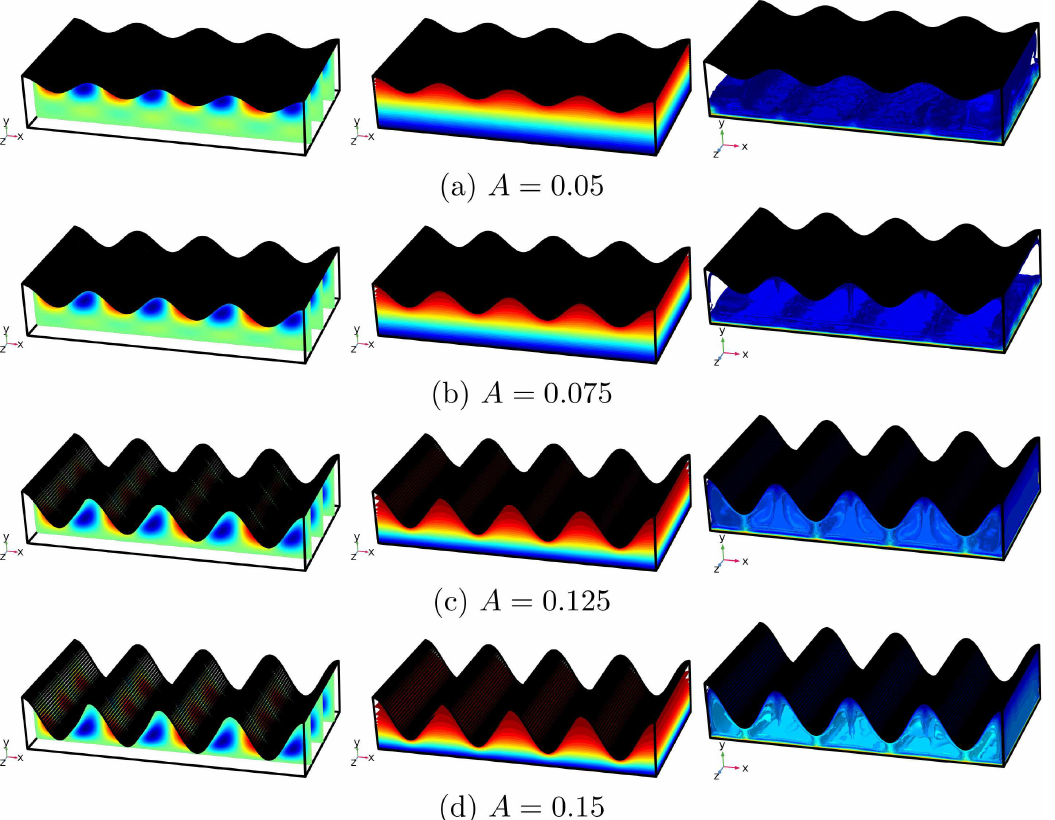
Figure 7. Variation of the 3D streamlines ( left ), isotherms ( middle ), and nanoparticle distribution ( right ) evolution by amplitude ( A ) for N = 4, Ra = 10 6 , and φ =